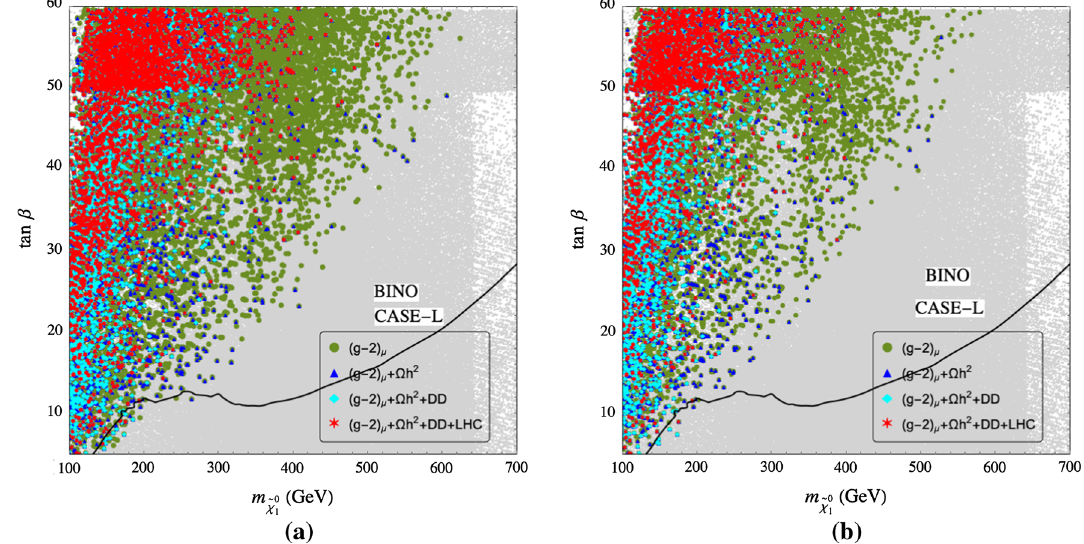
Fig. 17 The results of our parameter scan in the m ˜ χ 0 in the ˜ l -coannihilation case-L scenario for current (left) and antic- ipated future limits (right) from ( g − 2 ) μ . The color coding is